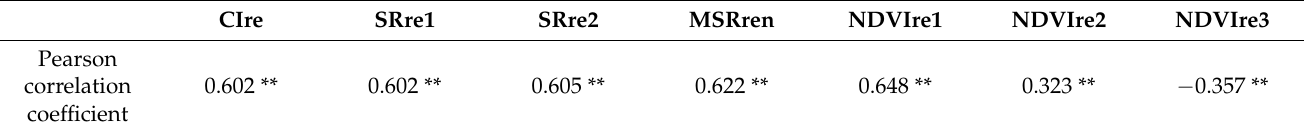
Table 7. Correlation coefficient matrix for red edge vegetation indices and CC.